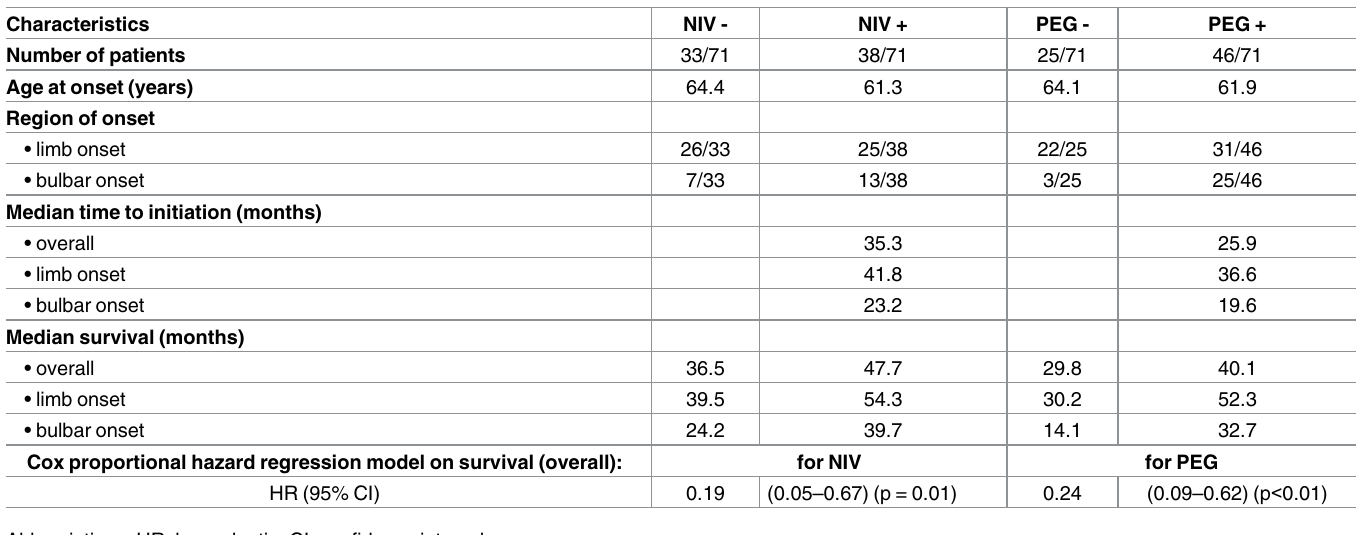
Table 2. Impact of NIV and PEG on survival *